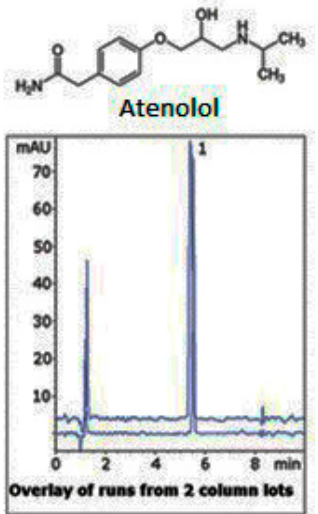
Figure 11. Analysis of the pharmaceutical compound atenolol on the Diamond Hydride column using the aqueous normal phase mode. Adapted from Reference